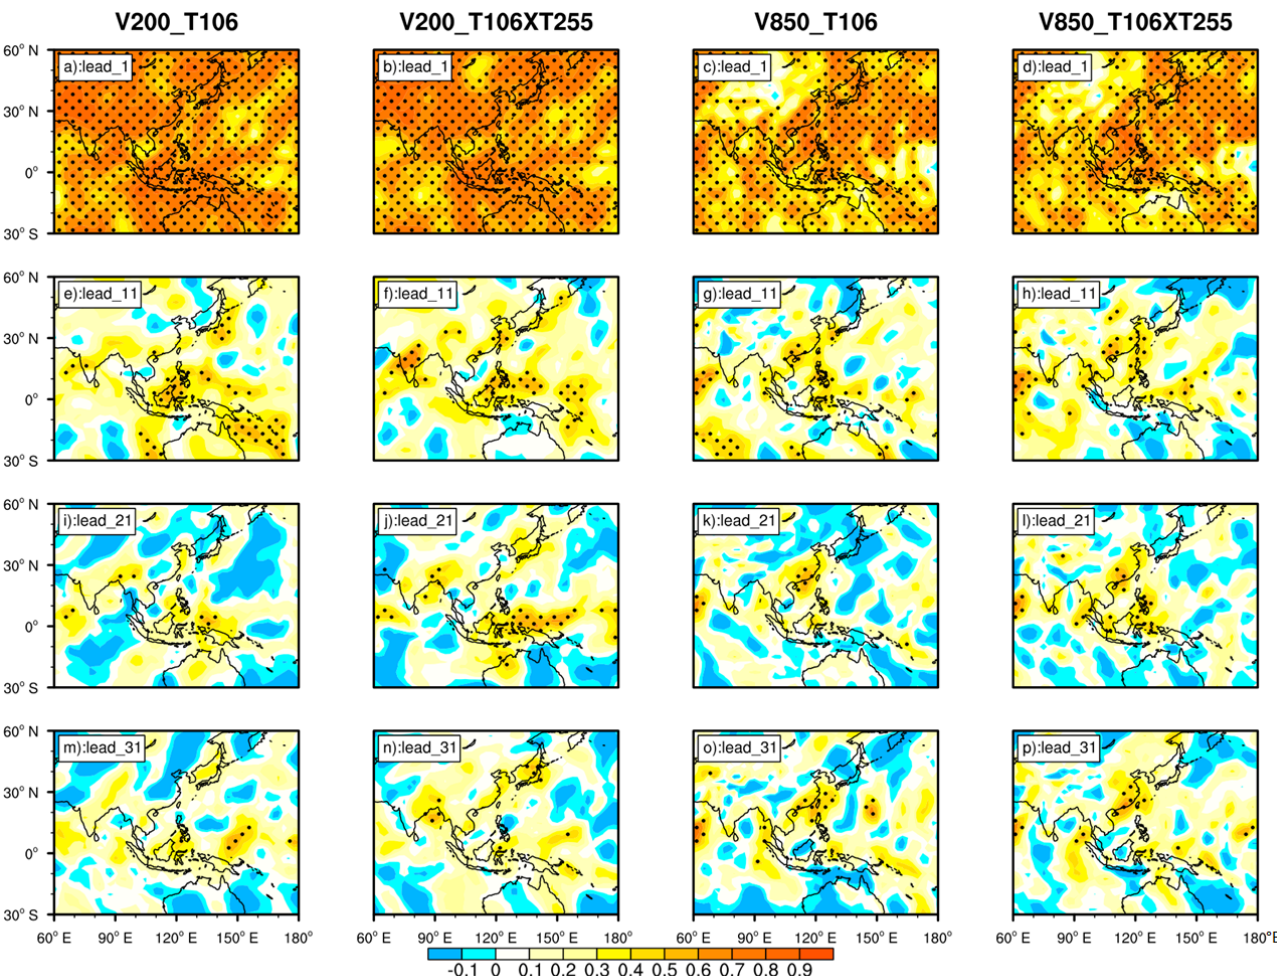
Figure 3. Same as Figure 2, but for 200 hPa and 850 hPa meridional wind. ( a , e , i , m ): 200 hPa meridional wind in T106; ( b , f , j , n ): 200 hPa meridional wind in T106 × T255; ( c , g , k , o ): 850 hPa meridional wind in T106; and ( d , h , l , p ): 850 hPa meridional wind in T106 ×